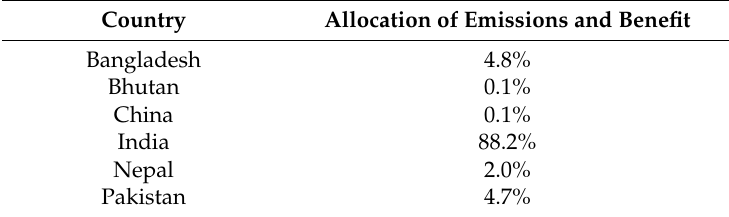
Table 5. County by country breakdown of the proportional benefit of SO 2 emissions mitigation according to relative economy size, reliance on rainfall for agricultural GDP generation and proportion of country included in the ISMR catchment area. Country Allocation of Emissions and Benefit Bangladesh 4.8% Bhutan 0.1% China 0.1% India 88.2% Nepal 2.0% Pakistan 4.7%